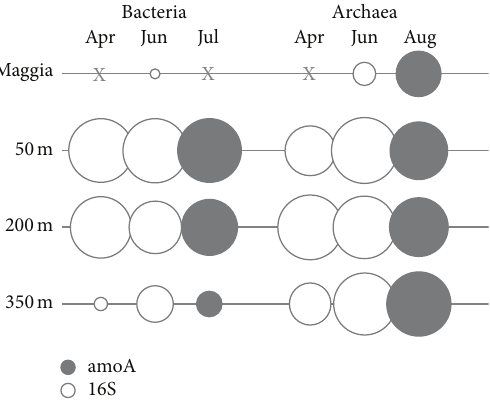
Figure 4: Bubble chart showing relative DGGE band intensities of lake water samples at 50, 200, and 350 m depth (Ghiffa pelagic station) and River Maggia in April, June, and August 2011. 16S rRNA and amoA gene patterns are displayed both for Bacteria and Archaea. X denotes absence of amplified bands. The primer sets applied are different between different amplifications, and the comparison between intensities should be considered only within the same set (vertical columns).